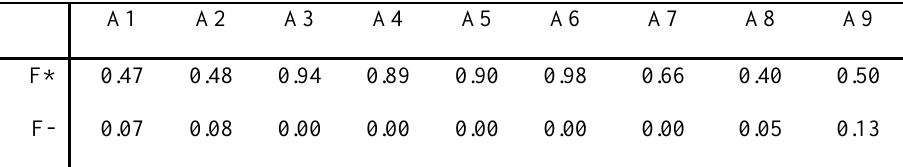
Table 4. Best and worst alternative for